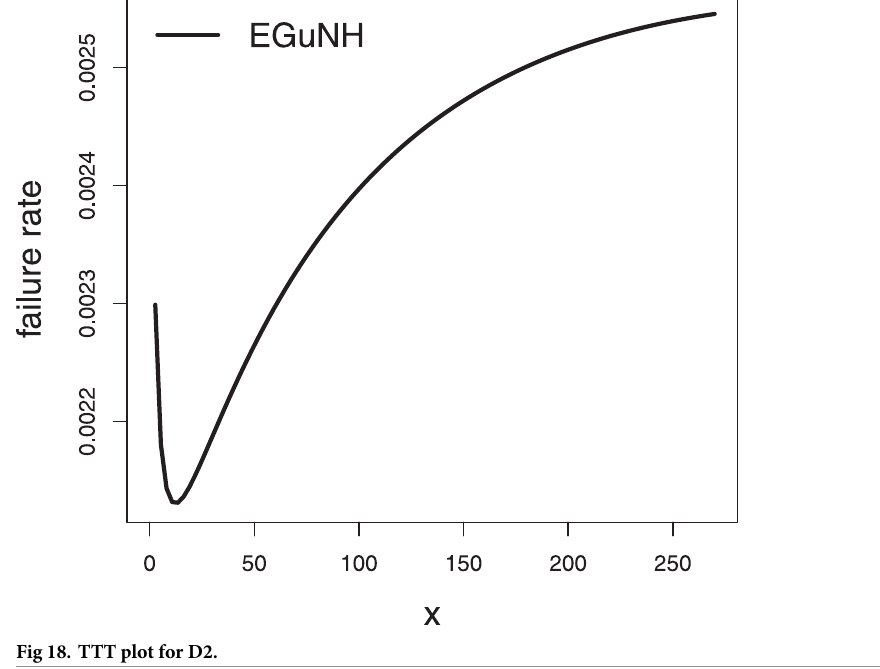
The empirical findings of all the three data are suggestive of the heavy tailed data. The TTT plots Figs (17)–(19) for the data sets are given. In particular, the TTT plots show bathtub, increasing and decreasing hrf, allowing us to fit EGuNH model on these data sets. The approxi- mated hrf Figs (20)–(22) for each data point correlates to the TTT graphs. Table 10 summarizes